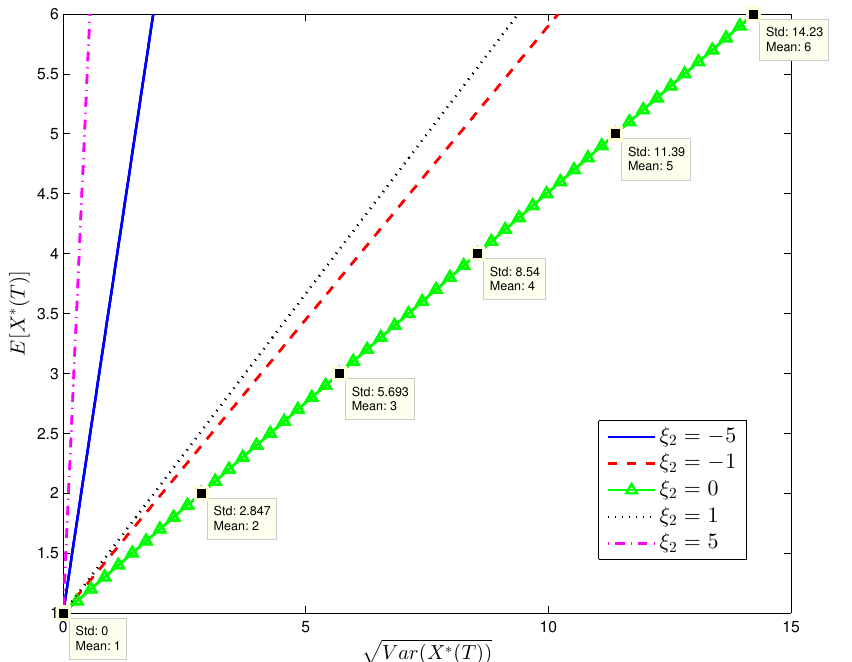
Figure 3. The efficient frontier in the complete market with different ξ 2 (In this figure, the values of (cid:112) V ar ( X ∗ ( T )) corresponding to E [ X ∗ ( T )] = i are reported for ξ 2 = 0, i = 1,2,3,4,5,6) .